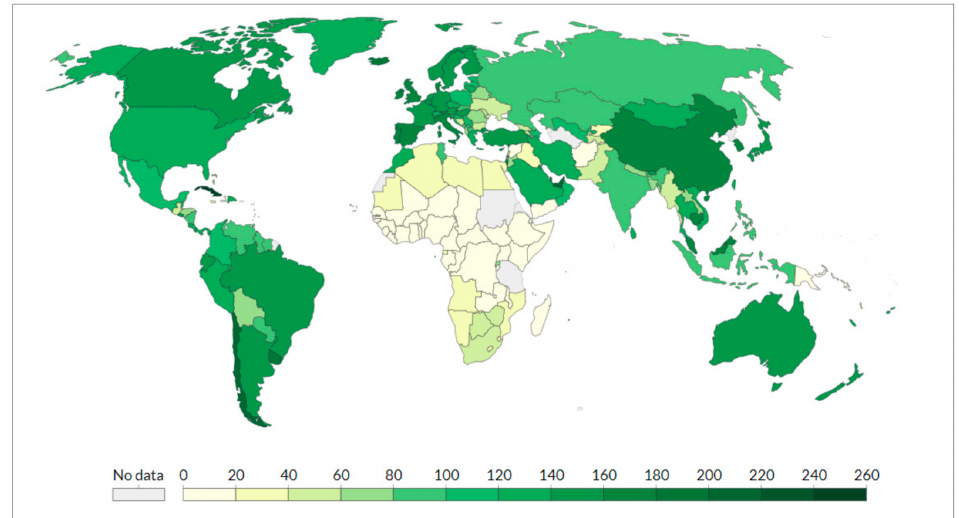
Figure 3. Total doses administered per 100 population worldwide (2 December 2021). OurWorldIn- Data.org. Available online: https://ourworldindata.org/coronavirus (accessed on 2 December